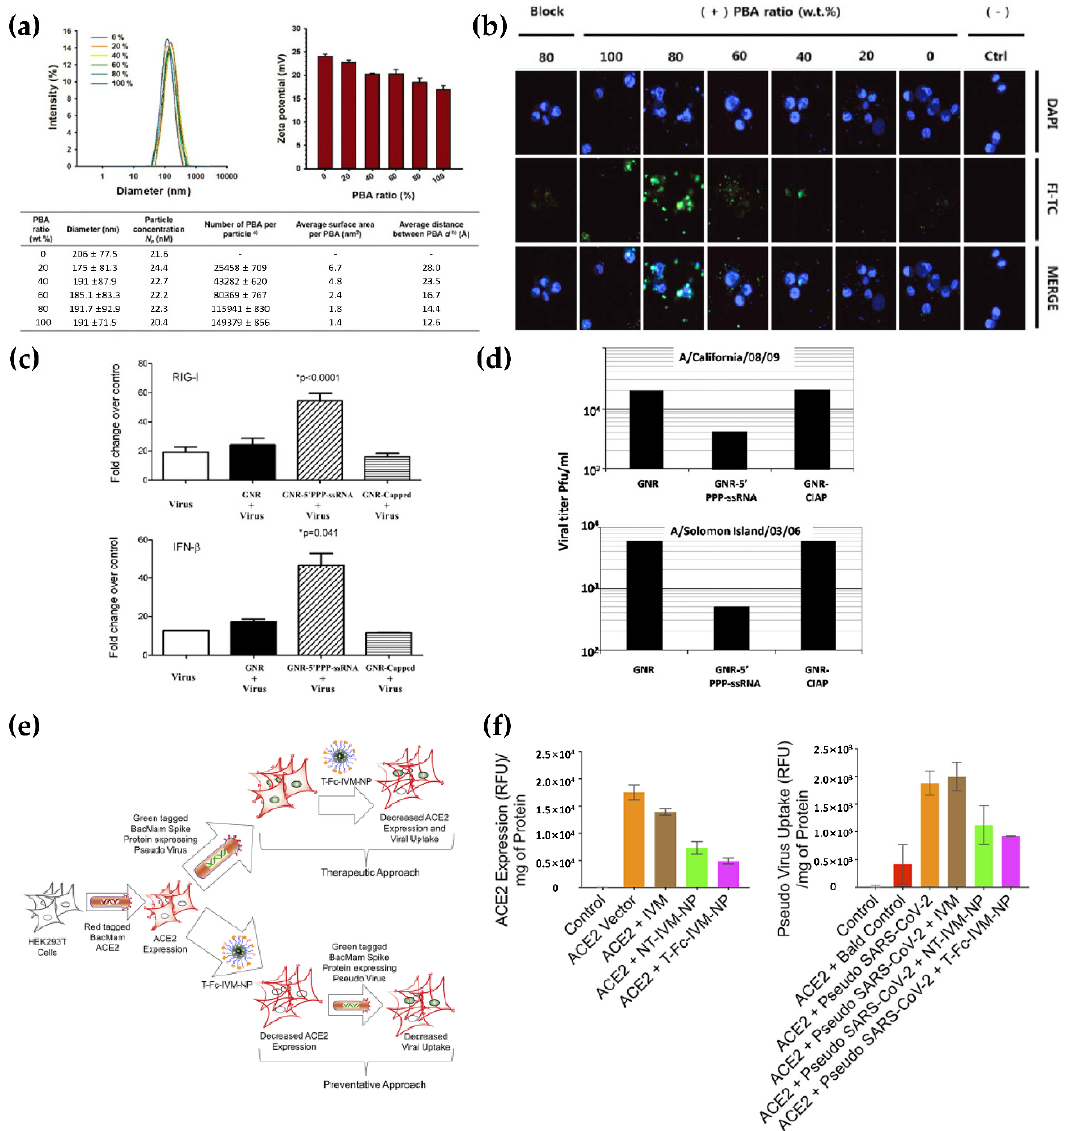
Figure 5. ( a ) Characterization of phenyl boronic acid (PBA)-conjugated polymersome (PBASome)-controlled inter-ligand distance between PBA conjugates. ( b ) Confocal laser scanning microscopy (CLSM) images of PBASomes in the presence of various weight fractions, as observed when stained for lectin. Green, fluorescein isothiocyanate; blue, DAPI; red, WGA. Reproduced with permission from [146]. Copyright (2018) Royal Society of Chemistry. ( c ) Enhanced expression of RIG-I and IFN- β in A459 cells treated with GNR-5 ′ PPP-ssRNA indicates inhibition of infection by H1N1 influenza virus and Solon Islands seasonal flu strain. ( d ) Inhibition of viral replication of the 2009 pandemic H1N1 influenza virus and Solomon Islands seasonal flu strain in the presence of GNR-5 ′ PPP-ssRNA, evaluated in A459 cell lines. Reproduced with permission from [169]. Copyright (2010) National Academy of Sciences. ( e ) Schematic of the mechanism of T-Fc-IVM-NP in HEK293T via decreased ACE2 expression and viral uptake. ( f ) Inhibition of ACE2 expression and pseudovirus uptake in HEK293T cells were evaluated using therapeutic (left) and preventative (right) treatment methods. Reproduced with permission from [170]. Copyright (2020) American Chemical Society .